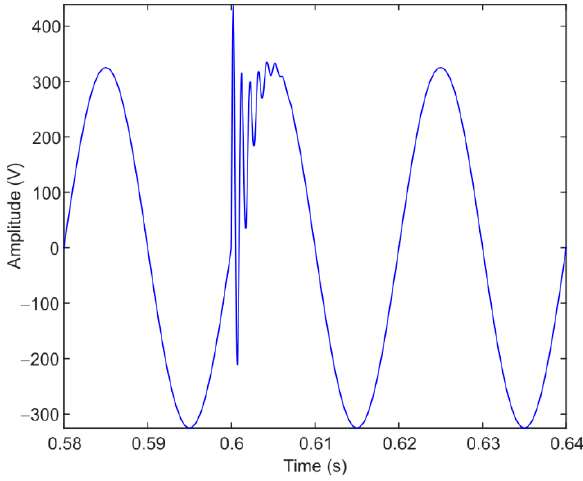
Figure 10. Model of fast transient disturbance with frequency oscillation of 1 kHz.